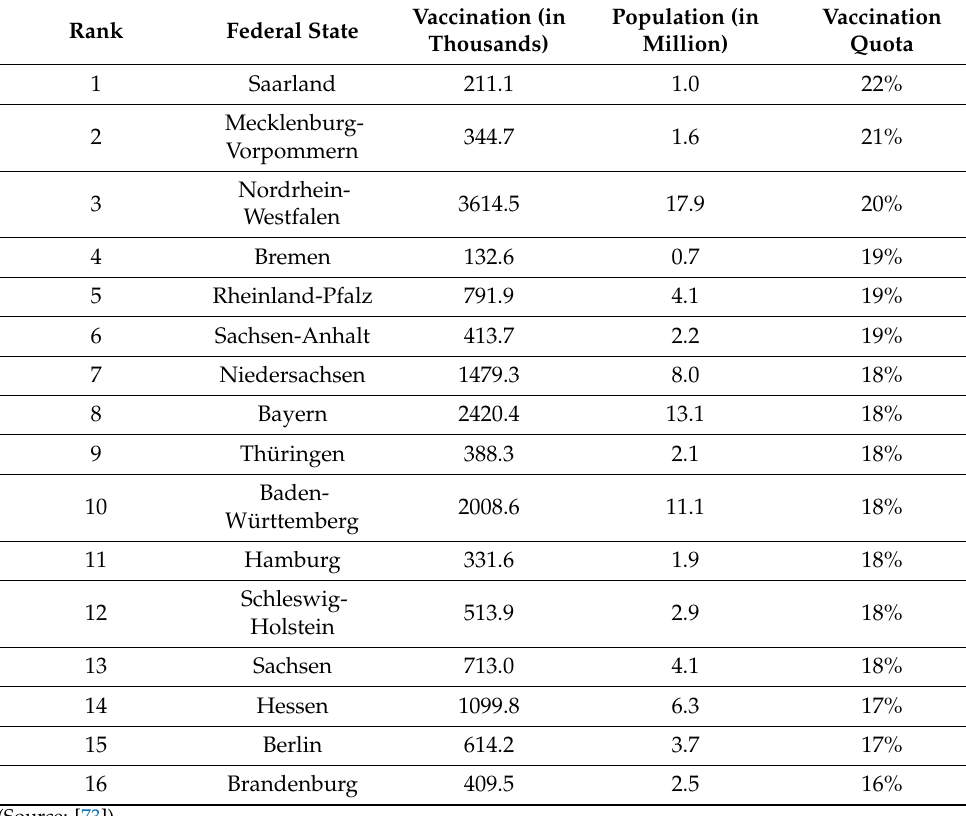
Table A3. Vaccination quota in Germany on 30 April 2021.